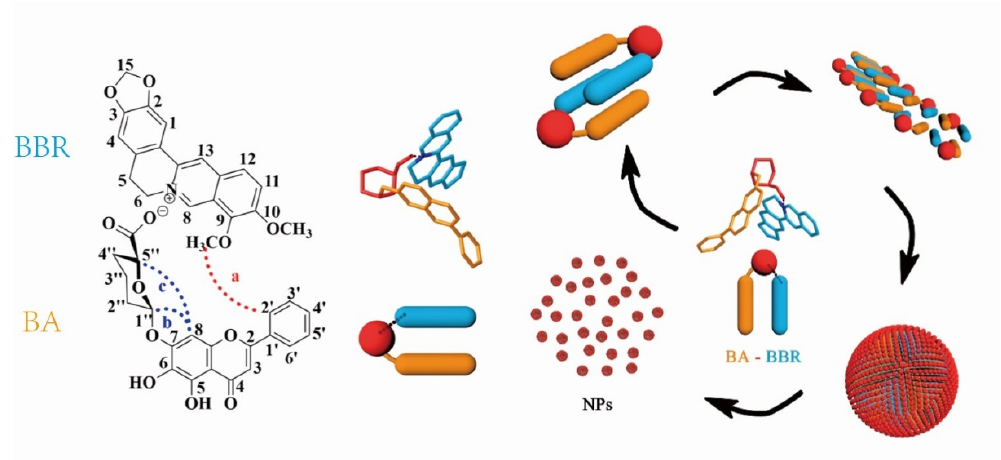
Figure 4. Schematic representation of the self-assembly mechanism of the berberine (BBR) and baicalin (BA) [61] .